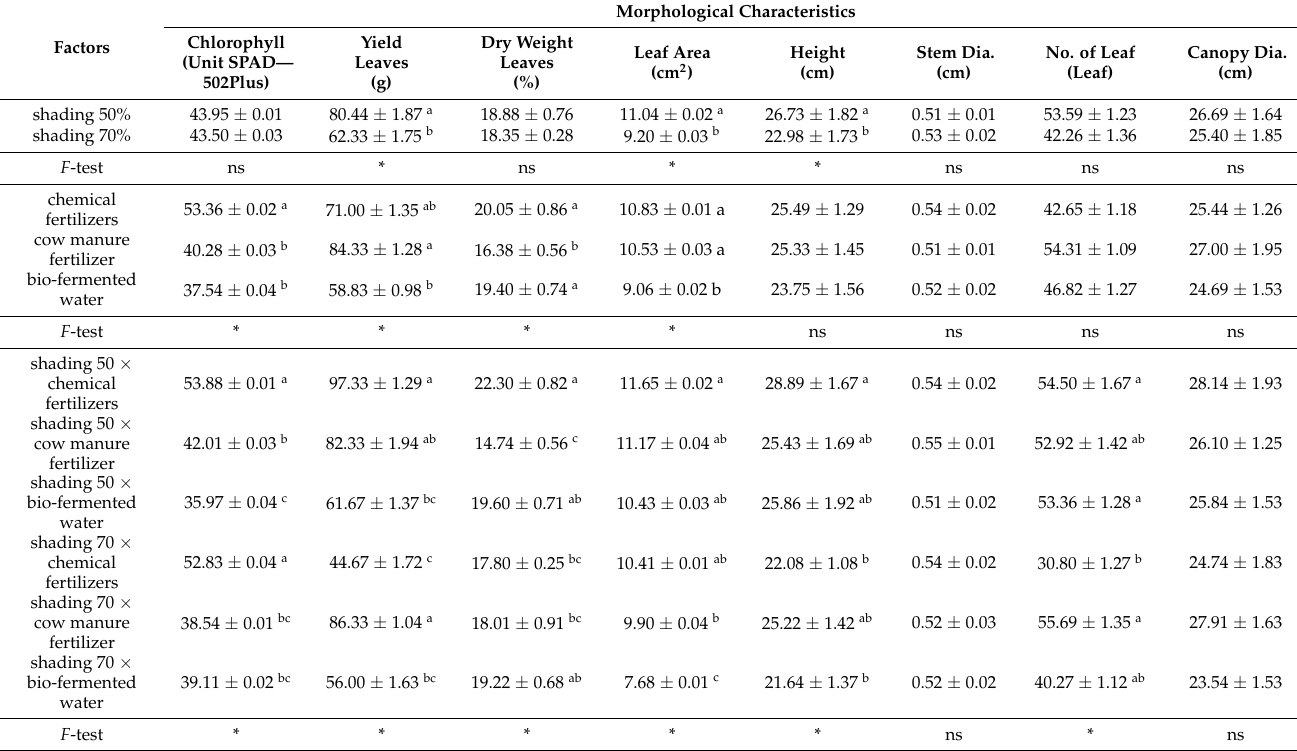
Table 2. Morphological characteristics of the Niamhom plant after two months of